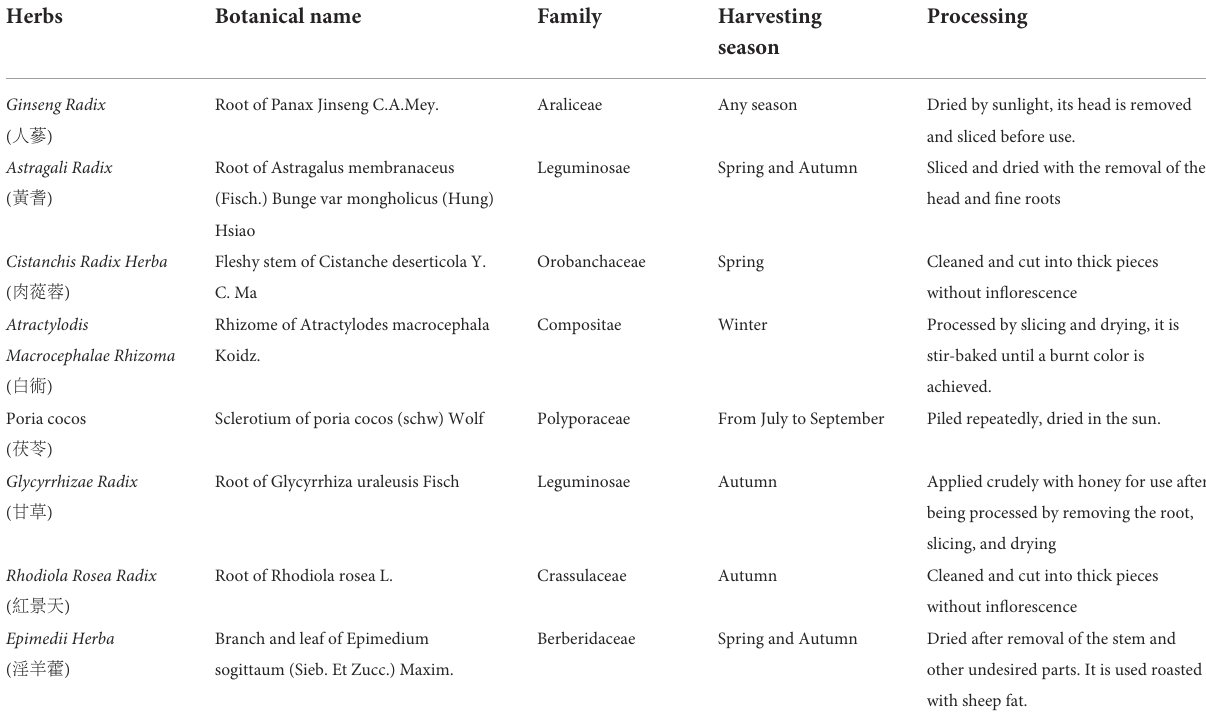
TABLE 1 Herbal ingredients of the Ji Wu li Plaster.